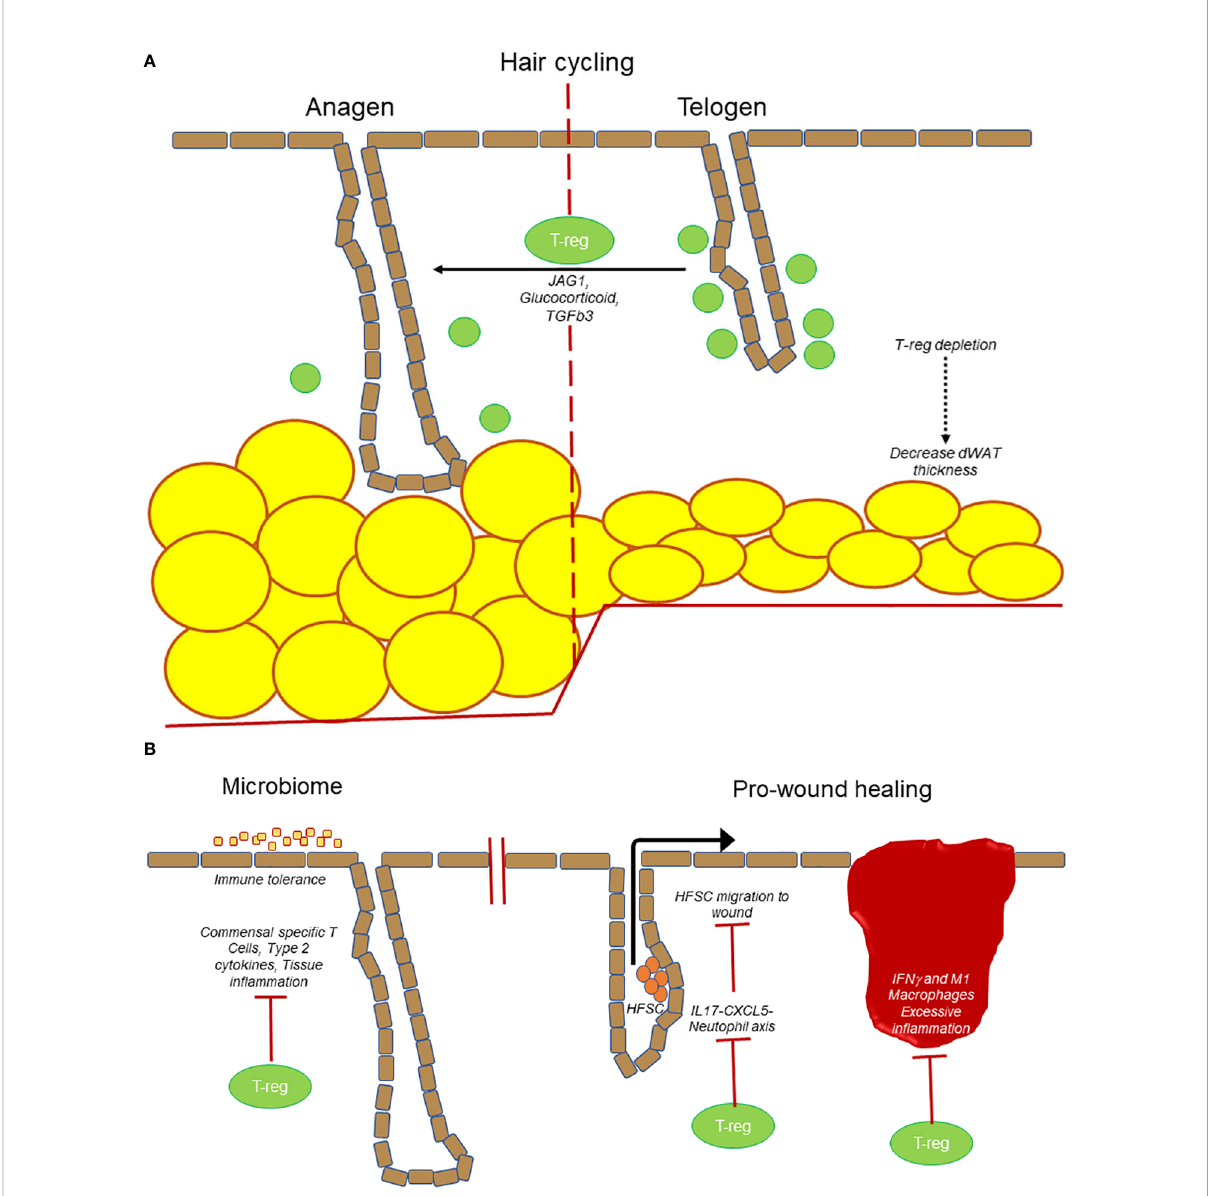
FIGURE 2 T-regs are at the center of many processes in the skin. (A) T-regs play a direct role in hair follicle cycling by promoting transition from telogen to anagen stage. Loss of T-regs also results in a decrease in dWAT thickness. (B) T-regs establish immune tolerance and prevent microbiome speci fi c in fl ammation. T-regs also promote wound healing by suppressing IL17-CXCL5-neutophil axis to promote hair follicle stem cell (HFSC) migration. T-regs prevent excessive in fl ammation (IFN g and M1 macrophages) to prevent delayed wound